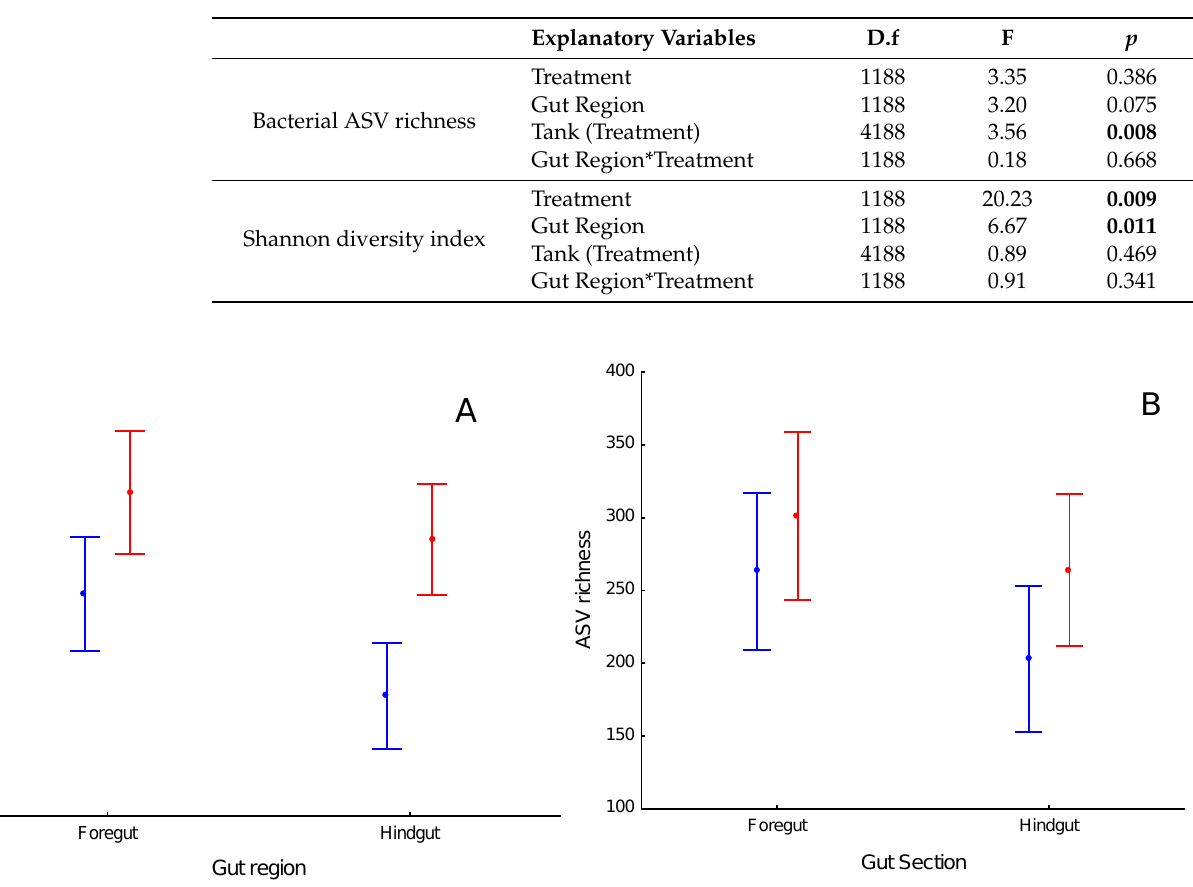
Table 1. General linear mixed models exploring the effects of the treatment (control and Allium - derived PTSO), and gut region as factors, and tank nested in treatment in the different alpha diversity indices of the bacterial community of gilthead seabream juveniles. D.f. refers to degree of freedom. The first number is the degree of freedom of the independent variable, and the second is for the error term. Significant p -values ( p < 0.05) are shown in bold.